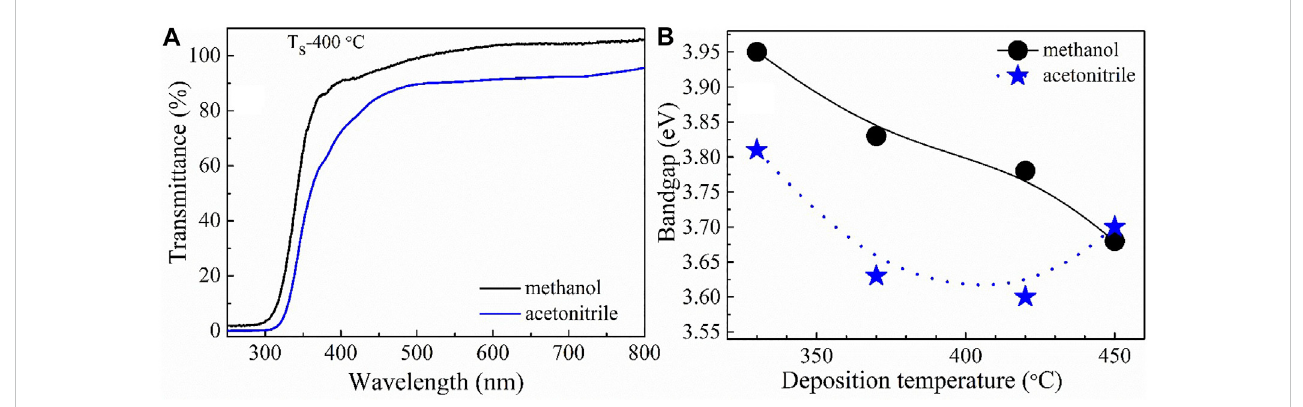
FIGURE 3 (A) Optical transmittance spectra of NiO with deposition temperature for NiO x fi lms deposited at T s = 400C from methanol- or acetonitrile-based